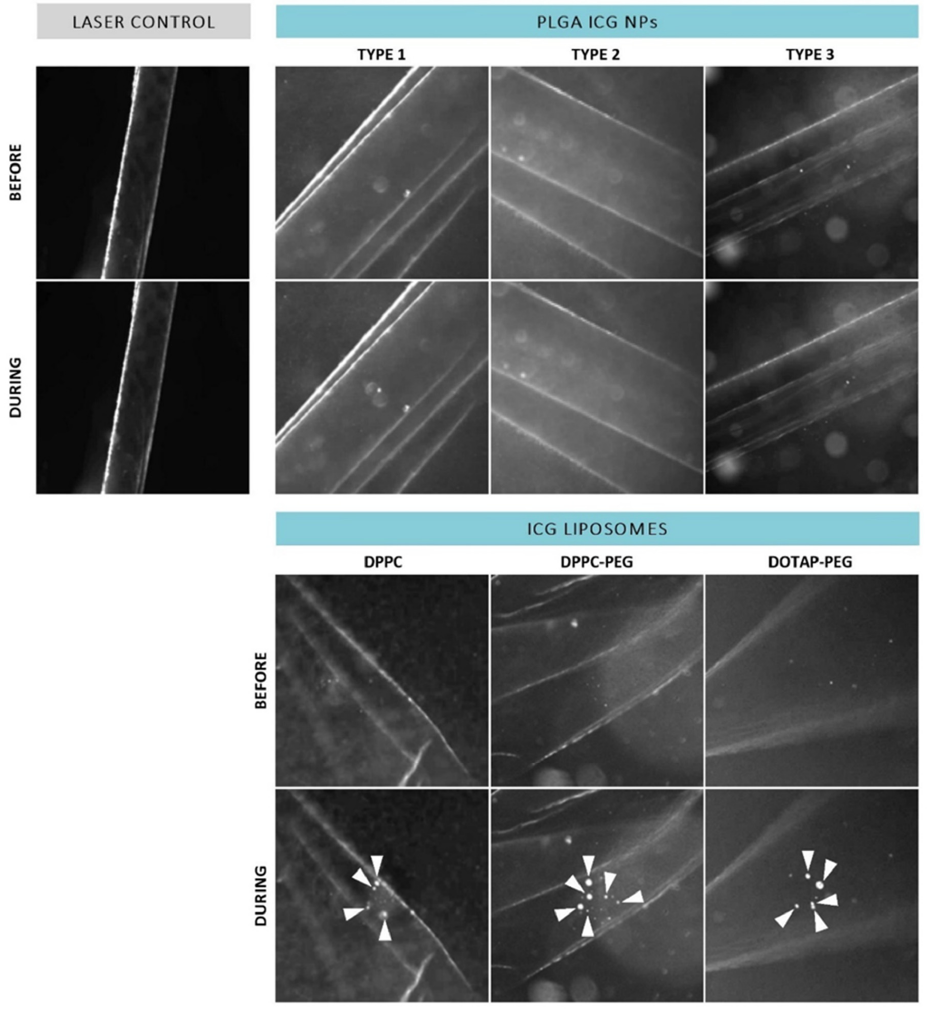
Figure 4. Dark field microscopy images of patient-derived isolated human ILM incubated with ICG NPs before and during application of a laser pulse (561 nm, ~ 3.6 J/cm 2 ). White arrowheads indicate presence of VNBs.